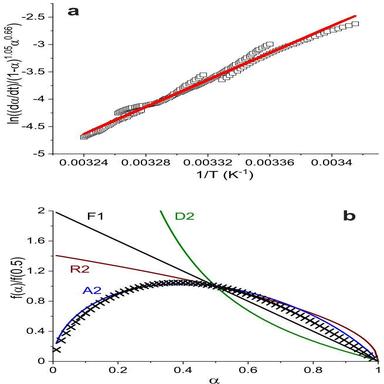
Plots resulting from the combined kinetic analysis. a, Combined kinetic analysis of experimental curves included in employing to determine n and m parameters resulting from the optimisation procedure. b, Comparison of the f(α) functions (solid lines) normalized at α=0.5.